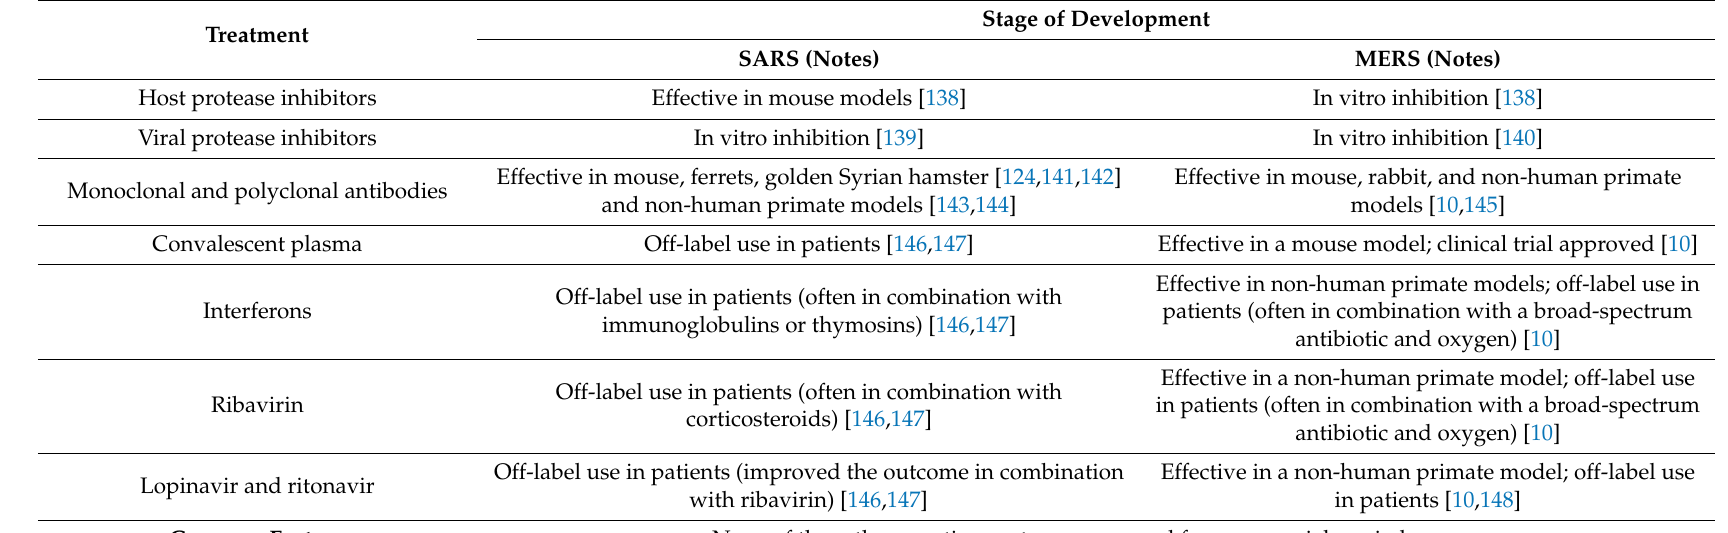
Table 4. Potential therapeutics for severe acute respiratory syndrome (SARS) and